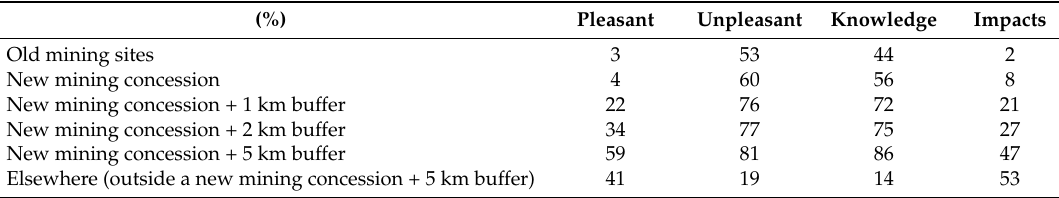
Table 6. Proportions of pleasant places, unpleasant places, places where more knowledge on the state of the environment is needed, and places where positive or negative impacts of mine reopening would be experienced in old mining sites, in the new mining concession, different buffer zones, and elsewhere in the landscape.